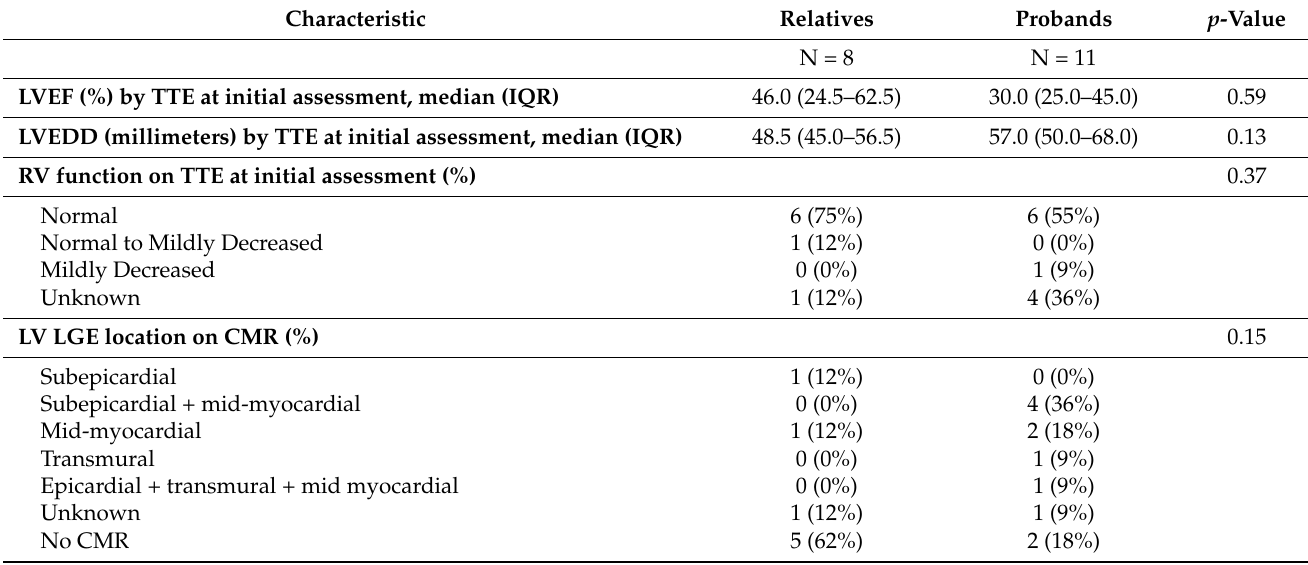
Table 4. Cardiovascular imaging characteristics of 19 probands and relatives with pathogenic or likely pathogenic variants in the desmoplakin gene ( DSP ). Abbreviations: TTE = two-dimensional transthoracic echocardiography; LVEDD = left ventricular end diastolic diameter; RV = right ven- tricular; LV = left ventricular; LGE = late gadolinium enhancement; CMR = cardiac magnetic resonance